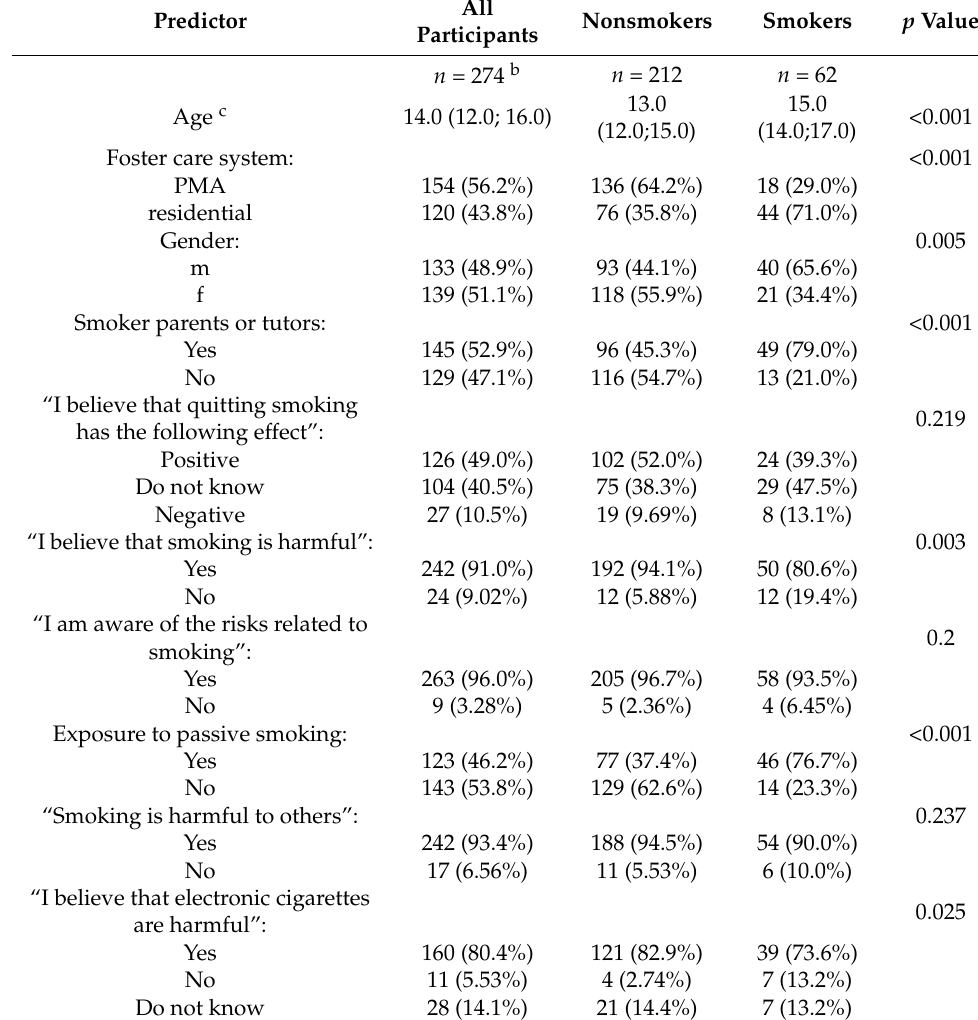
Table 1. Univariate analysis of potential predictors a for current smoker status in foster care teenagers. All Nonsmokers Predictor Participants